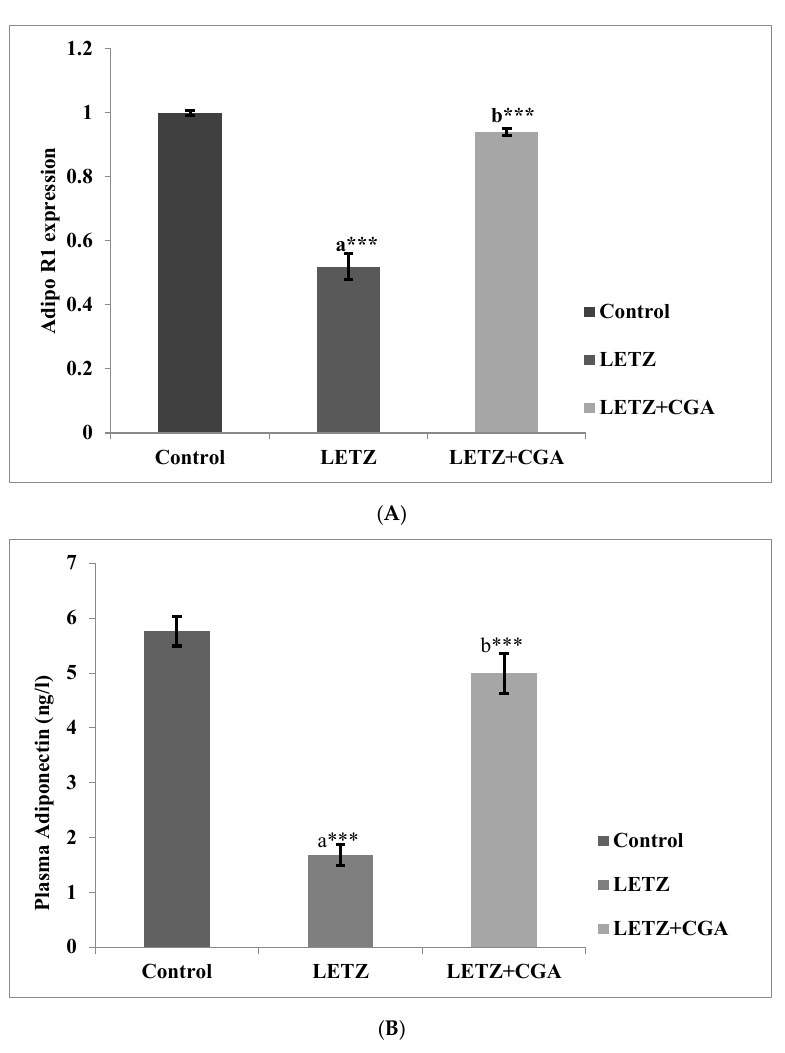
Figure 5. ( A ) Effect of CGA on Adipo r1 expression in mice with PCOS. Control: normal saline; PCOS: letrozole (6 mg/kg); PCOS with CGA: LETZ at 6 mg/kg and CGA at 50 mg/kg; a = LETZ versus control; b = LETZ versus LETZ with CGA. With n = 6 per group, all values are expressed as means with standard errors. *** p < 0.001; CGA = chlorogenic acid; LETZ = letrozole. ( B ) Effect of CGA on adiponectin levels in mice with PCOS. Control: normal saline; PCOS: letrozole (6 mg/kg); PCOS with CGA: LETZ at 6 mg/kg and CGA at 50 mg/kg); a = LETZ versus control; b = LETZ versus LETZ with CGA. With n = 6 per group, all values are expressed as means with standard errors. *** p < 0.001; CGA = chlorogenic acid; LETZ = letrozole.